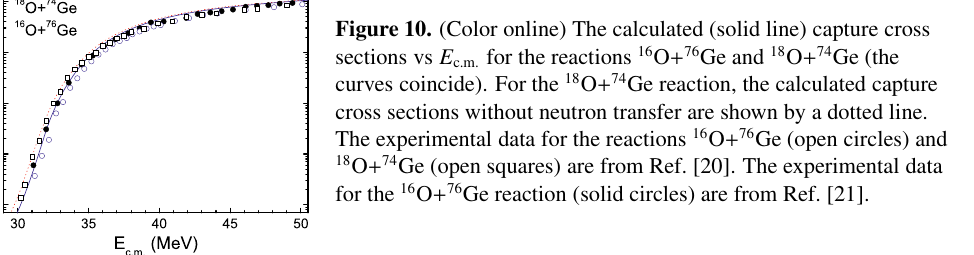
Figure 10. (Color online) The calculated (solid line) capture cross sections vs E c . m . for the reactions 16 O + 76 Ge and 18 O + 74 Ge (the curves coincide). For the 18 O + 74 Ge reaction, the calculated capture cross sections without neutron transfer are shown by a dotted line. The experimental data for the reactions 16 O + 76 Ge (open circles) and 18 O + 74 Ge (open squares) are from Ref. [20]. The experimental data for the 16 O + 76 Ge reaction (solid circles) are from Ref.